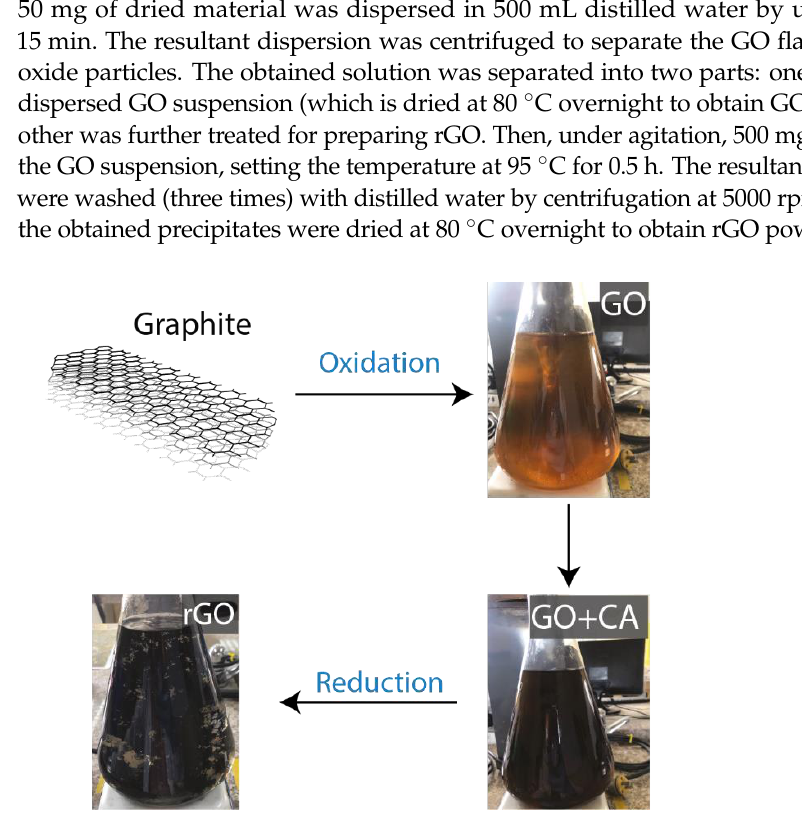
Figure 1. Scheme of the synthesis process of oxidized graphenes, i.e., GO and rGO. The GO+CA suspension acquired a dark color after 20 min of continuous stirring.